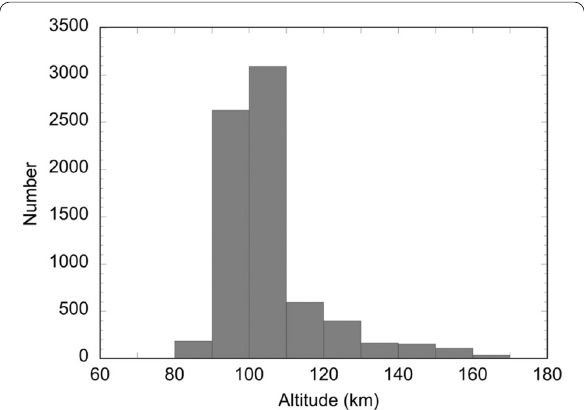
Fig. 4 Histogram of the distribution of Es layer altitude for Kokubunji in 2009. The manually scaled 1-h data obtained by the NICT ionosonde were used. The plot indicates that Es layers appear most often in the 100–110 km altitude